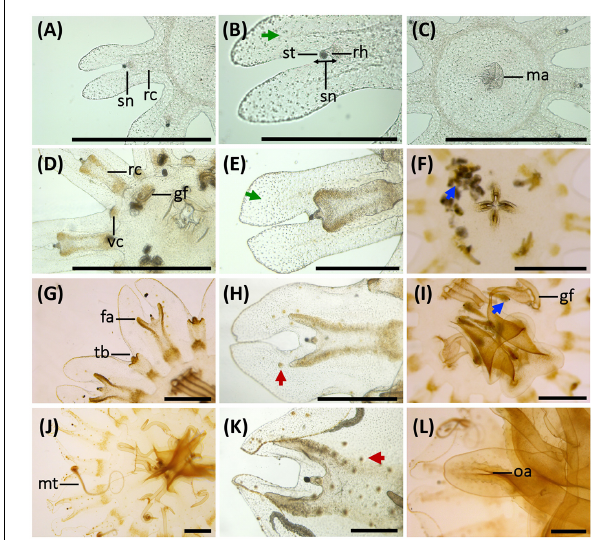
FIGURE 4 | Morphological changes, development of gastric system and cnidae in early stages of the life cycle of Pelagia noctiluca . (A–C)